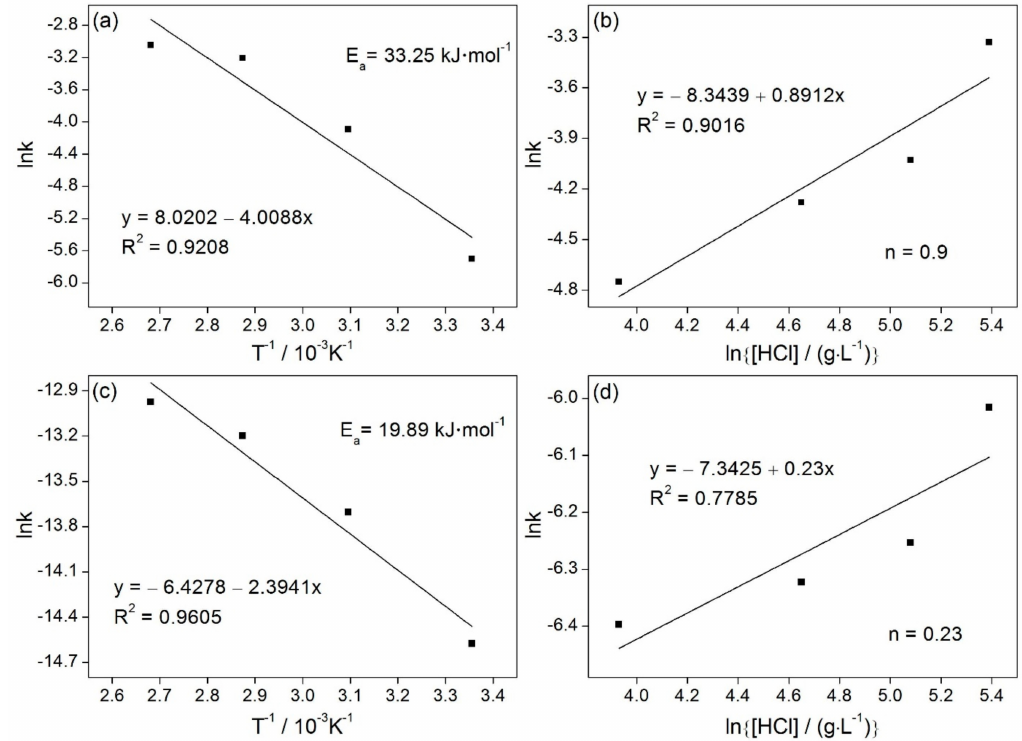
Figure 4. Relationship between lnk/T − 1 and lnk/ln[HCl] during leaching process: ( a , b ) for iron, ( c , d ) for